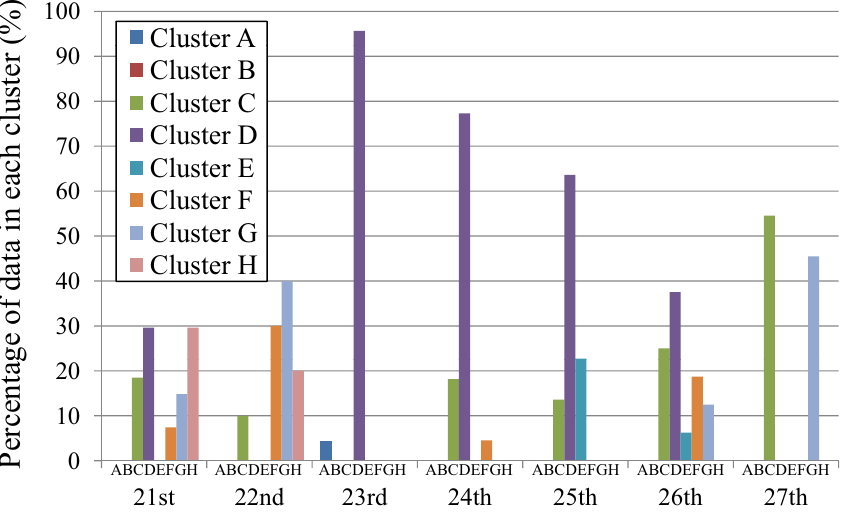
Figure 8. Distribution of temperature in each cluster for the whole week (August 21–27,